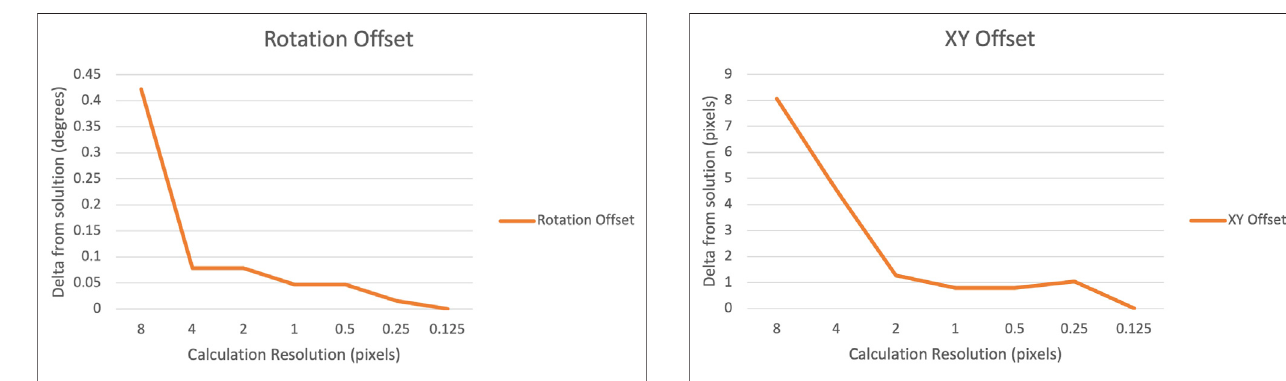
Frontiers in Remote Sensing |